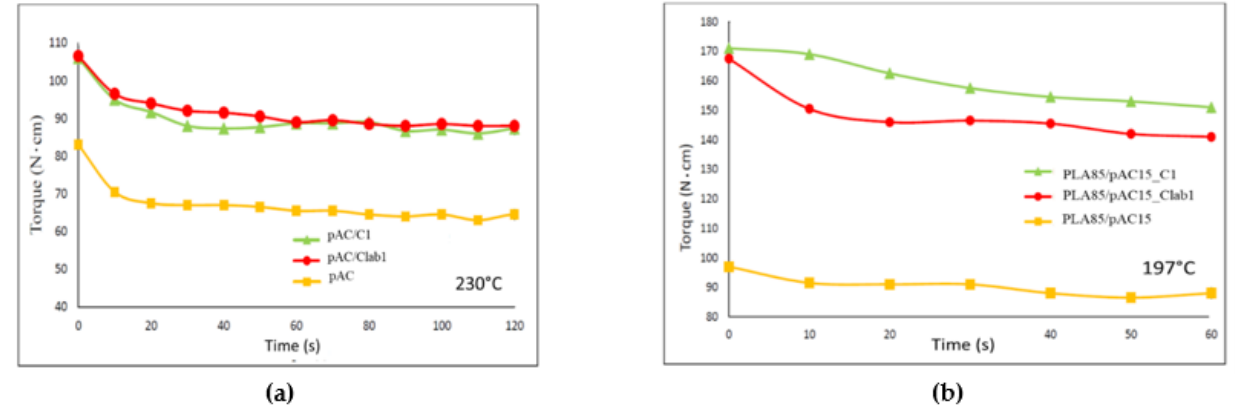
Figure 5. Torque vs. time trends: ( a ) extrusion of the plasticized AC with C1 or Clab1 (pre-blending) at 230 °C; ( b ) extrusion of blends containing 85% by weight of PLA at 197 °C [24] .